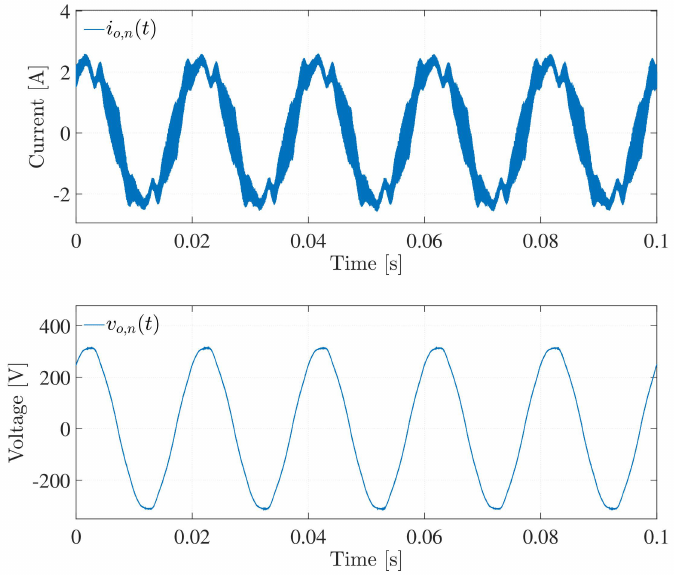
Figure 13. The output voltage, v o , n ( t ) , and current, i o , n ( t ) , under normal operating